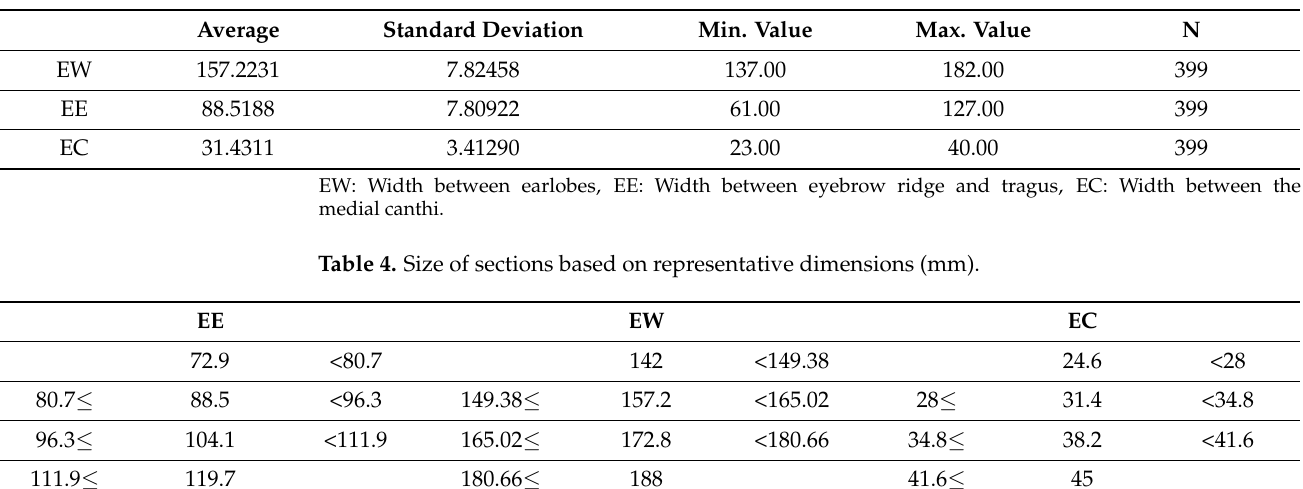
Table 3. Average and standard deviation of representative dimension items (mm).